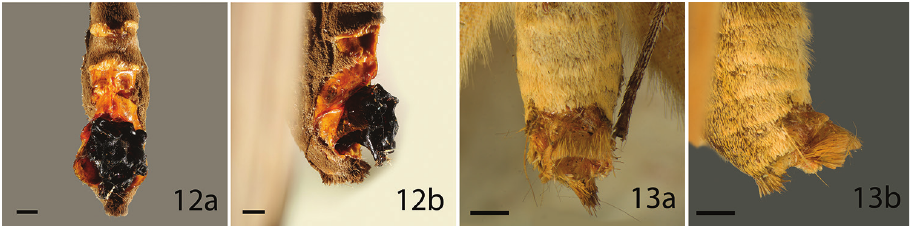
Figures 12, 13. Sphragis of butterfly species, a ventral b lateral, category of the sphragis in parenthesis. 12 Amauris niavius (1) 13 H. penelope (4). Scale bar = 1 mm.